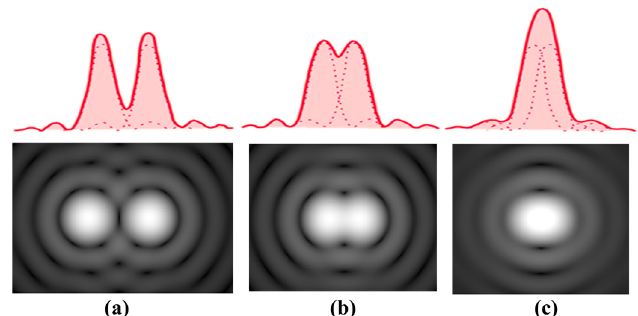
Figure 5. Airy diffraction patterns generated by light from two points passing through a circular aperture. ( a ) Points far apart; ( b ) Rayleigh criterion; ( c ) points closer than Rayleigh criterion [29,30].